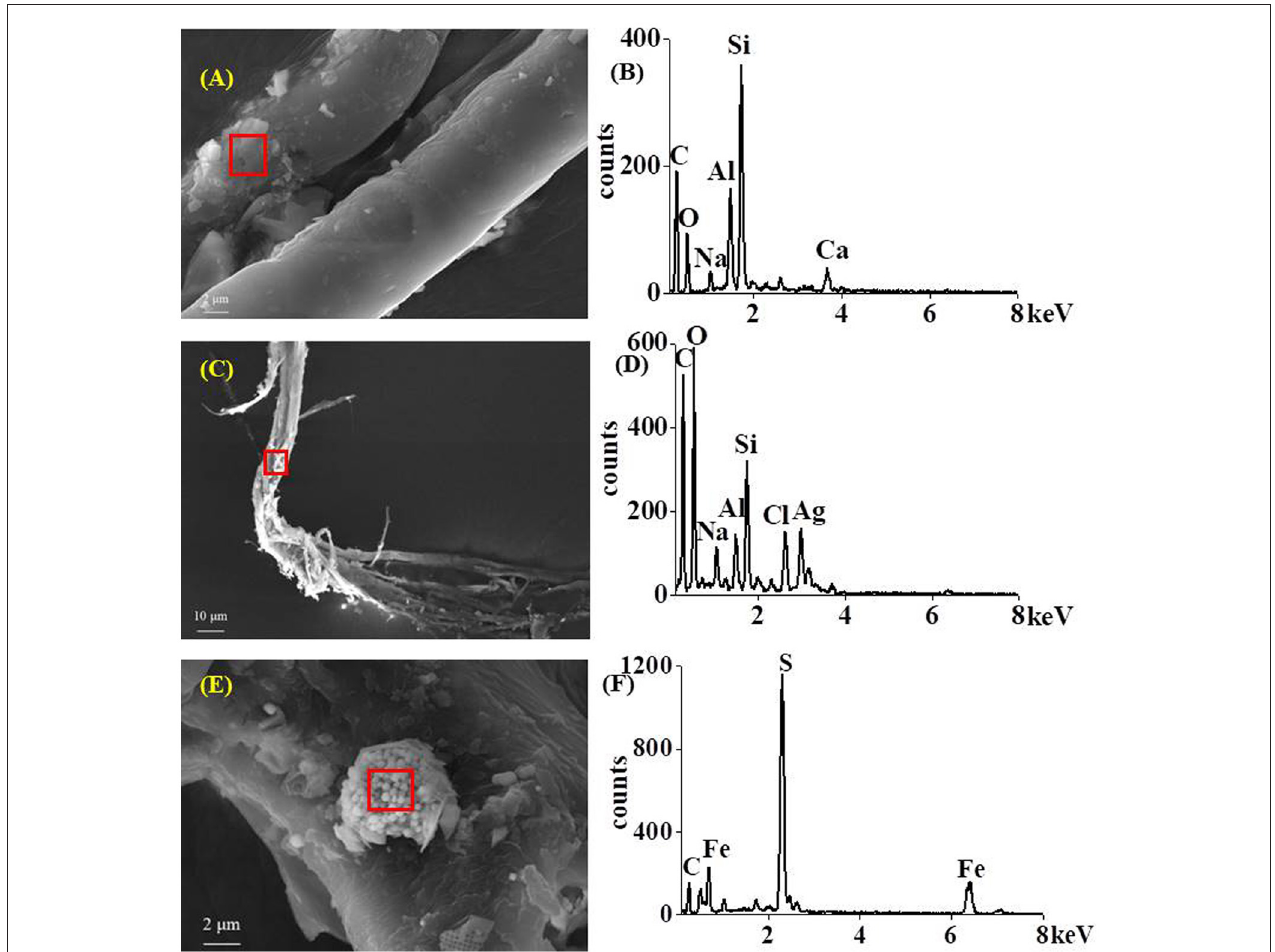
FIGURE 5 | Scanning electron microscope (SEM) images and energy spectra showing the substances on the surfaces of micro-fibers in the halocline [PP, (A,B) ] and near-bottom layer [PB, (C,D) ] and sediment [PP, (E,F) ] in the Baltic Sea.